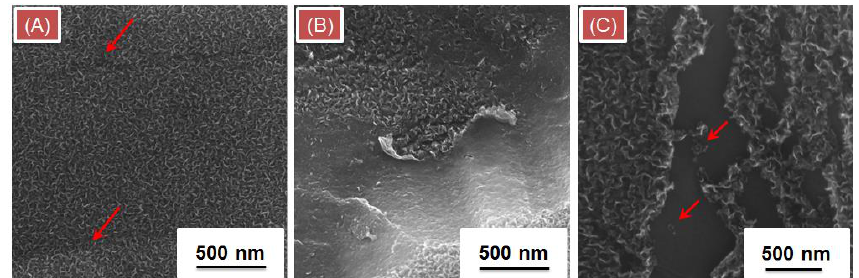
Figure A4. ( A – C ) Representative FE-SEM images of VOG coatings prepared on the copper foil substrate after 1 min of deposition time and heating treatment: 40 min at 450 ◦ C at 2/5 partial pressure of propane in {C 3 H 8 + Ar} gas mixture. Red arrows in ( A ) point to the defects of copper foil caused during the industrial manufacturing process and in ( C ) to the VOG nucleation